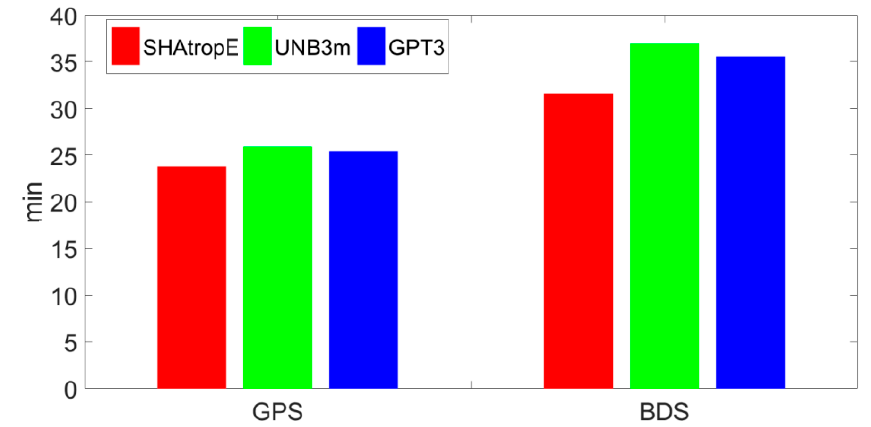
Figure 12. Average convergence time of static PPP with three different tropospheric models (SHAtropE (red), UNB3m (green), and GPT3 (blue)) for the GPS-only and BDS-only solutions.